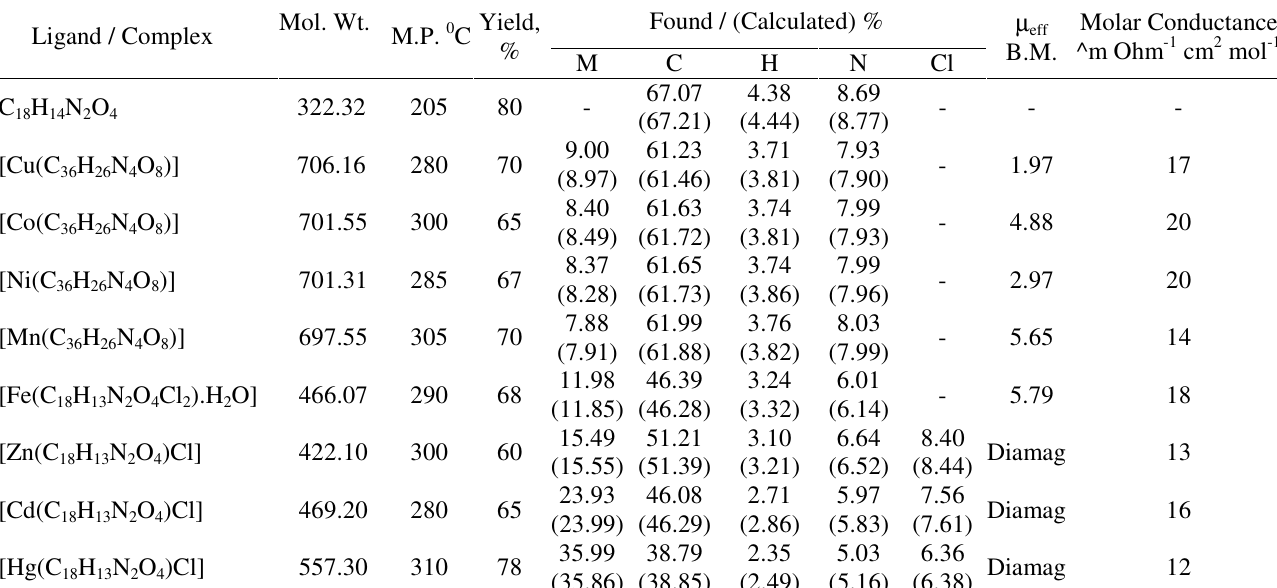
Table 1. Analytical, magnetic susceptibility, molar conductance of the ligand [HL] and its metal complexes. Ligand /